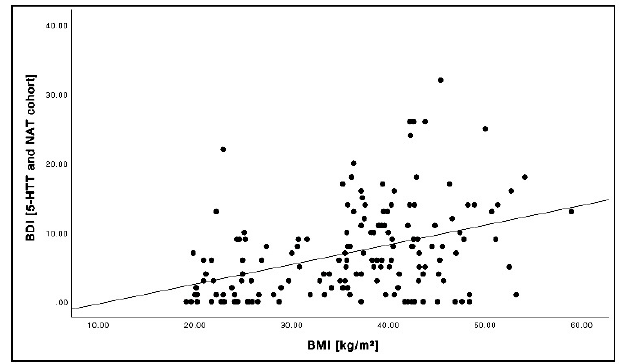
Figure 1. Relationship between the BMI (kg/m 2 ) and BDI across the cohorts (pooled baseline and follow-up data).